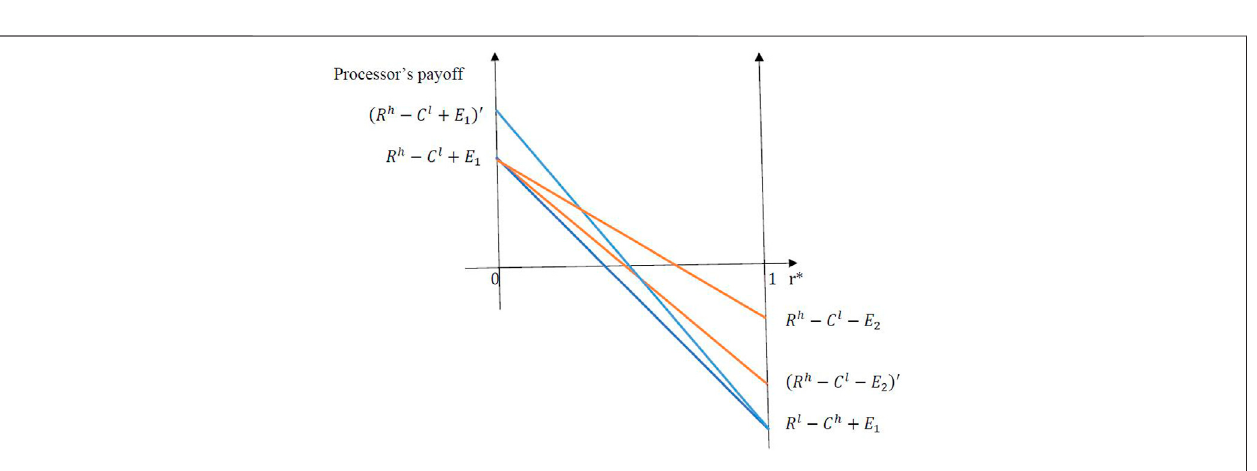
FIGURE 2 | Relationship between the processor ’ s payoff and the probability of a spot